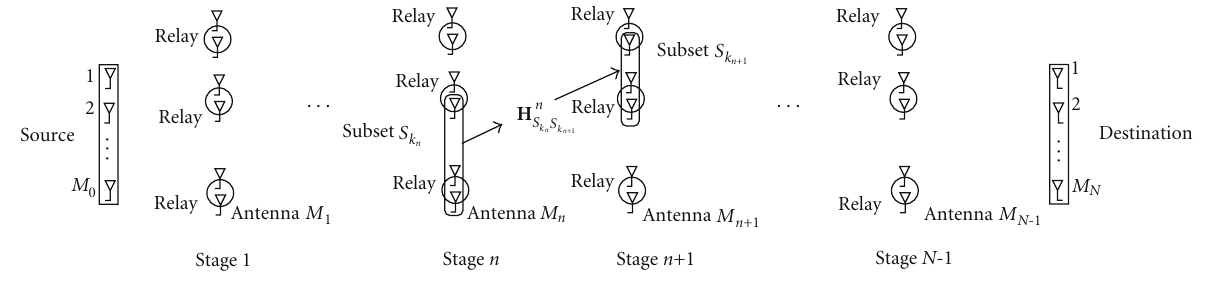
Figure 1: System block diagram of a multi-hop relay channel with N − 1